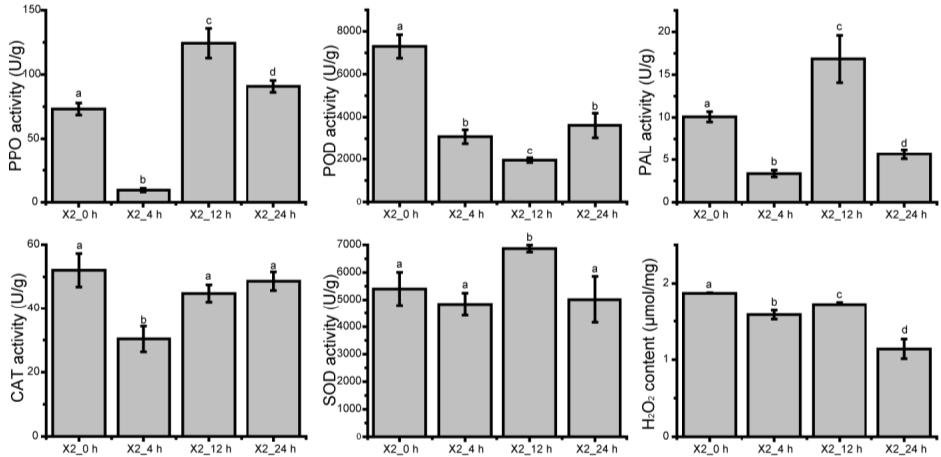
Figure 7. Enzyme activity and H 2 O 2 content in potato tubers after cutting. Data are mean values ± SE for three independent replicates. Means denoted by different letters indicated a significant dif- ference at p < 0.05 according to a Tukey’s test.